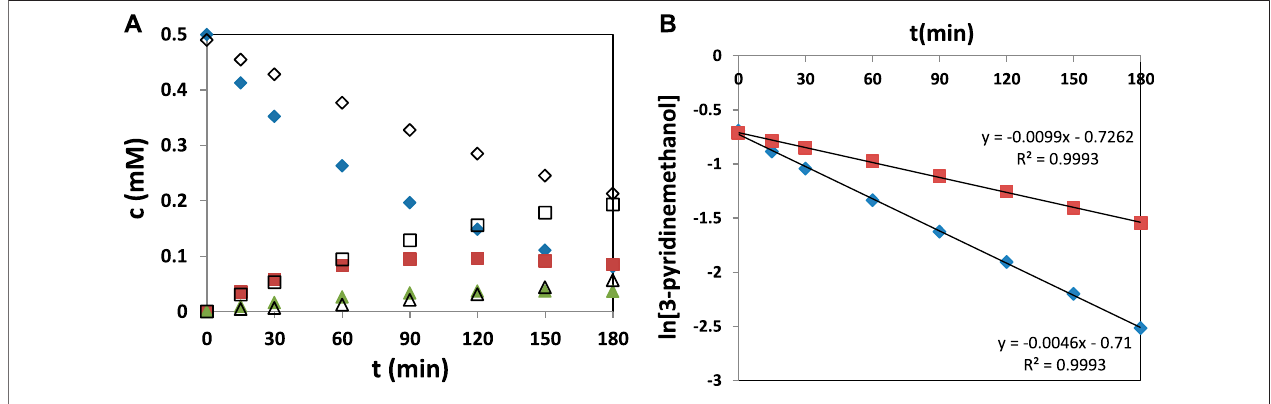
FIGURE 8 | (A) The results of photocatalytic oxidation of 3-pyridinemethanol ( ◆ , ◊ ) to 3-pyridinemethanal ( ■ , □ ) and vitamin B 3 ( ▲ , Δ ) versus time in the presence of Degussa P25 (full symbols) and